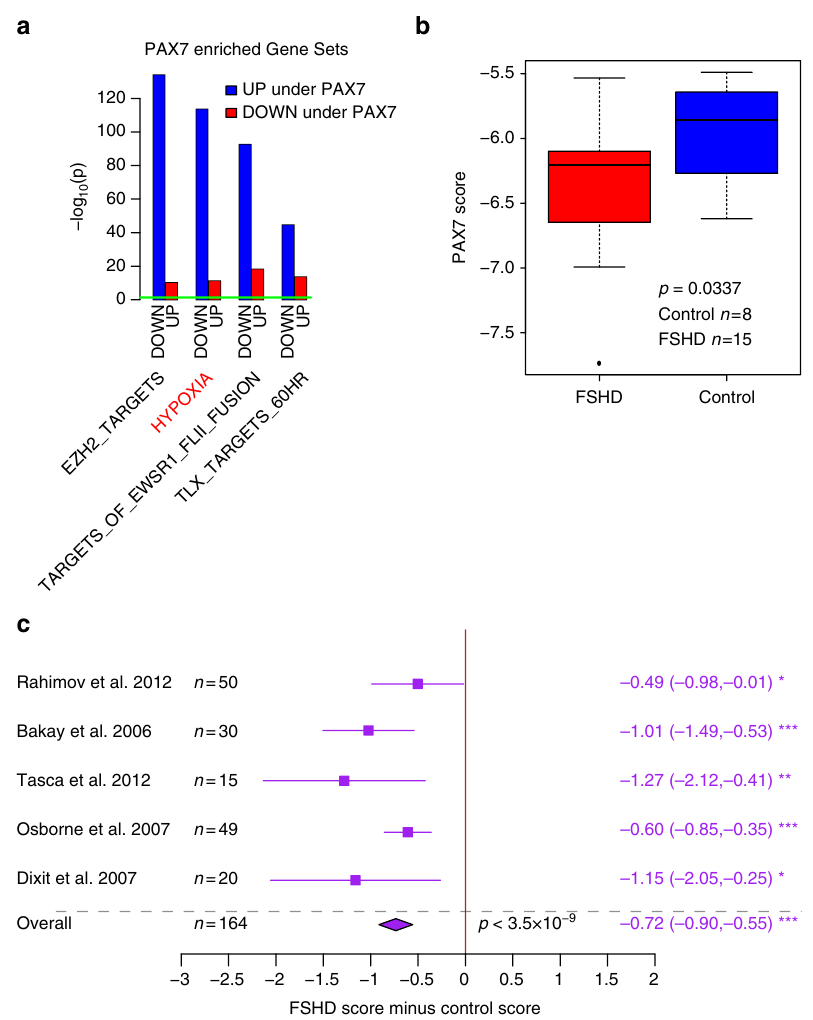
Fig. 3 PAX7 target gene signature is a robust hallmark of FSHD skeletal muscle. a Gene set enrichment analysis was performed separately for activated and repressed targets of PAX7 against the Molecular Signatures database (MSigDB) 37, 38 . Gene sets in MSigDB are frequently partitioned into ‘‘ genes upregulated in phenotype ’’ and ‘‘ genes downregulated in phenotype ’’ . If such opposing gene sets were inversely signi fi cantly enriched across activated and repressed PAX7 targets (as assessed by Fisher ’ s exact test), they were considered robust. A bar plot displays the − log 10 (enrichment p- value) for PAX7 robust gene sets. A horizontal green line denotes p = 0.05. UP and DOWN on the x-axis refers to the partition of labeled gene sets into genes positively and negatively associated with the gene set respectively. PAX7 targets are enriched for repression of a HYPOXIA gene set, which speci fi cally describes genes upregulated and downregulated following over-expression of a constitutively active form of HIF1 α . Another gene set affected by PAX7 repression is EZH2 target genes. b A box plot demonstrates that the PAX7 target gene signature derived from 311 upregulated target genes and 290 downregulated target genes, validates as a biomarker on the RNA-seq FSHD muscle biopsy data set published by Yao et al. 10 . The box represents the interquartile range (IQR), with the median indicated by a line. Whiskers denote min (1.5*IQR, max (observed value)). ‘‘ o ’’ represents data points greater than 1.5 IQR from the median, n = 15 FSHD and n = 8 control muscle biopsies. The two-tailed Wilcoxon U -test p- value is given. c A forest plot displays the results of meta- analysis of the discriminatory power of the PAX7 target gene signature across fi ve published microarray FSHD muscle biopsy data sets (in total n = 82 FSHD and n = 82 control muscle biopsies). The differential scores (FSHD score minus control score) alongside 95% con fi dence intervals are provided. Our PAX7 target gene signature is a signi fi cant biomarker on every individual FSHD muscle biopsy data set, and is strongly signi fi cant on meta-analysis. For single studies, a two-tailed Wilcoxon U -test was performed to assess signi fi cance, while a Fisher ’ s combined test was employed for overall assessment: *denotes p < 0.05, **denotes p < 0.01 and ***denotes p <